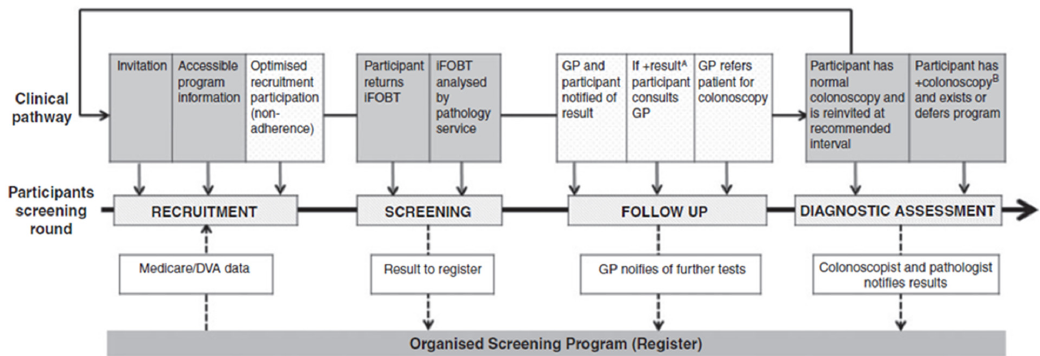
Figure 2. The modified National Bowel Cancer Screening Program Quality Framework, version 2. A A positive (+) result means that blood was detected in the completed immunochemical fecal occult blood test (iFOBT). B A positive colonoscopy is identified by reporting one of the following: tubular adenoma, tubulovillous adenoma, villous adenoma, sessile serrated adenoma, traditional serrated adenoma, adenoma not otherwise classified, or